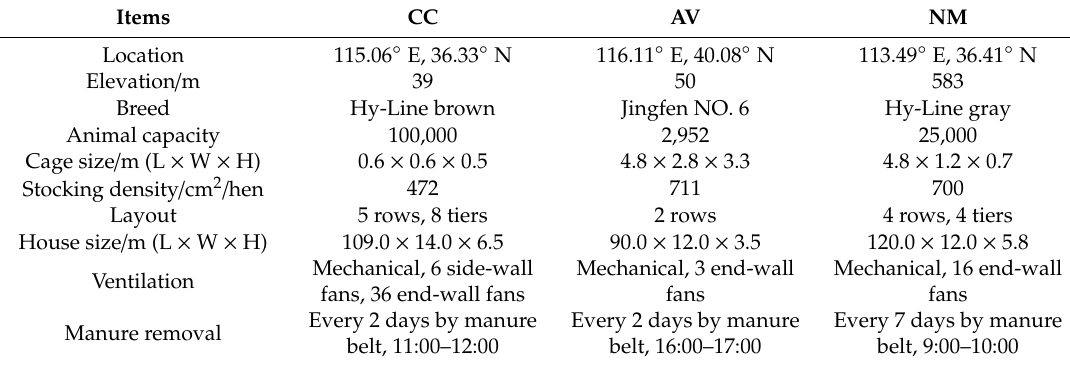
Table 1. Description of the three laying hen houses